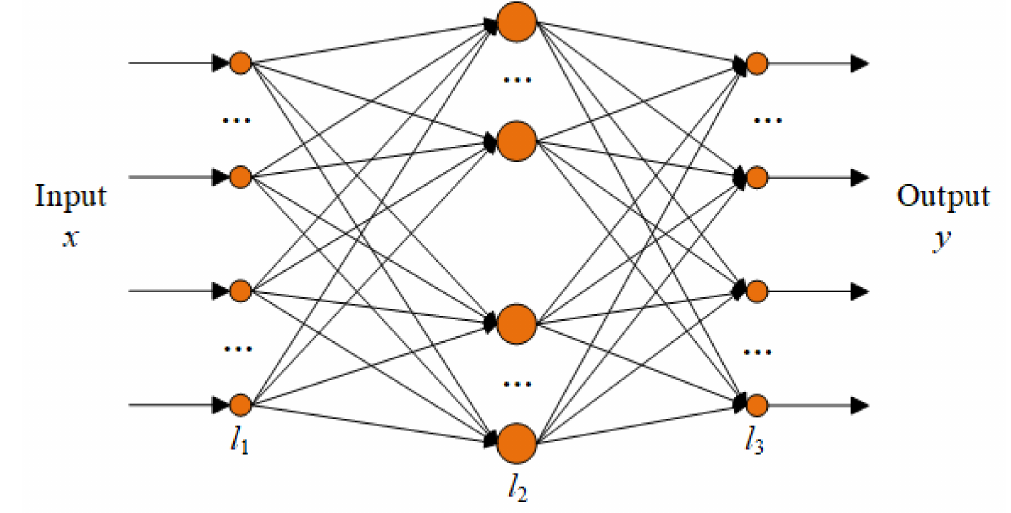
Figure 4. BP neural network